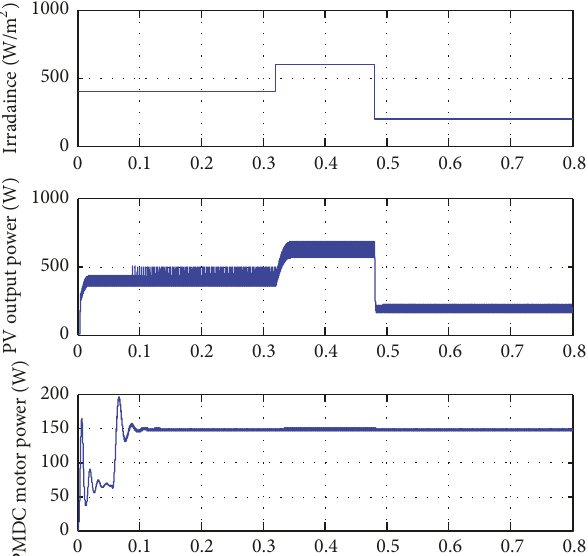
Figure 23: Peak extracted power from PV and PMDC input power at various solar irradiation values.